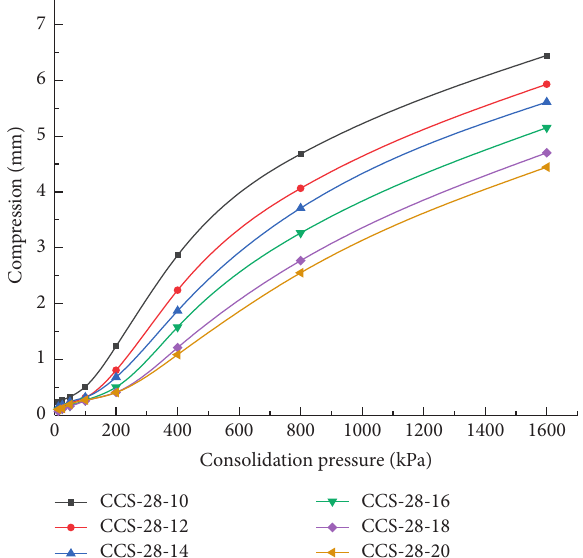
Figure 3: The compression amount-consolidation pressure curves of